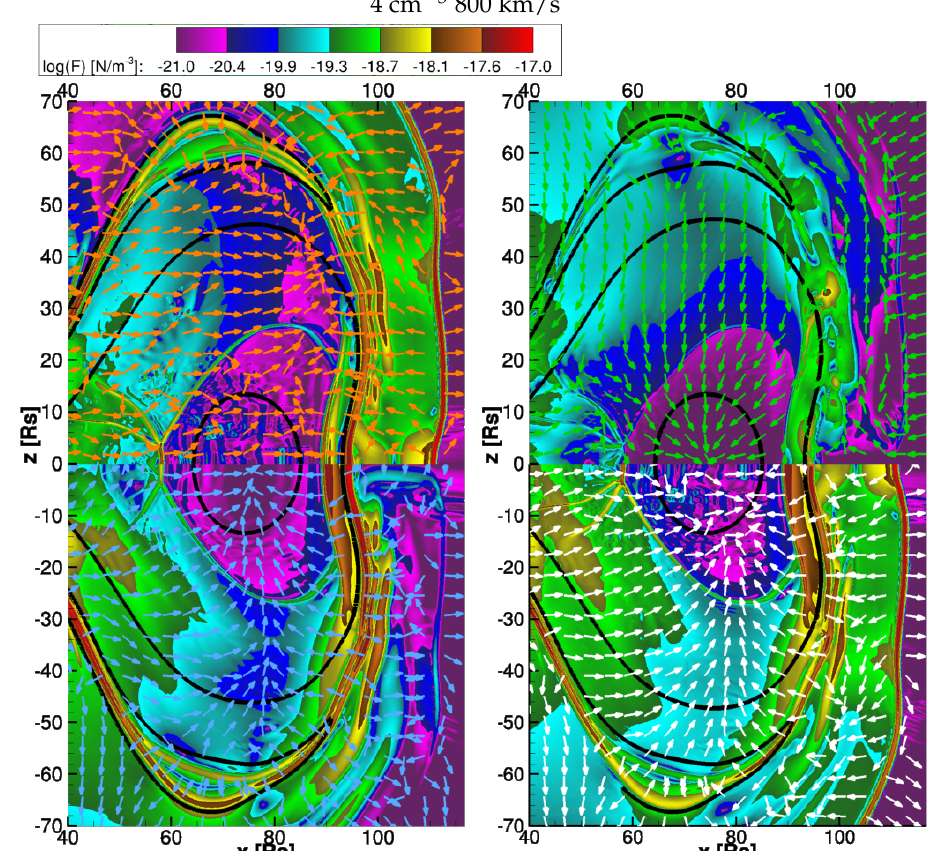
Figure 4. Forces that act upon a normal CME ejected in a low density background wind with a medium initial velocity 20 h after initiation. Colour Contours represent the magnitude of the force and the vectors represent the direction of the force. Upper left: Plasma pressure gradient. Upper right: Magnetic tension. Lower left: Magnetic pressure gradient. Lower right: Total